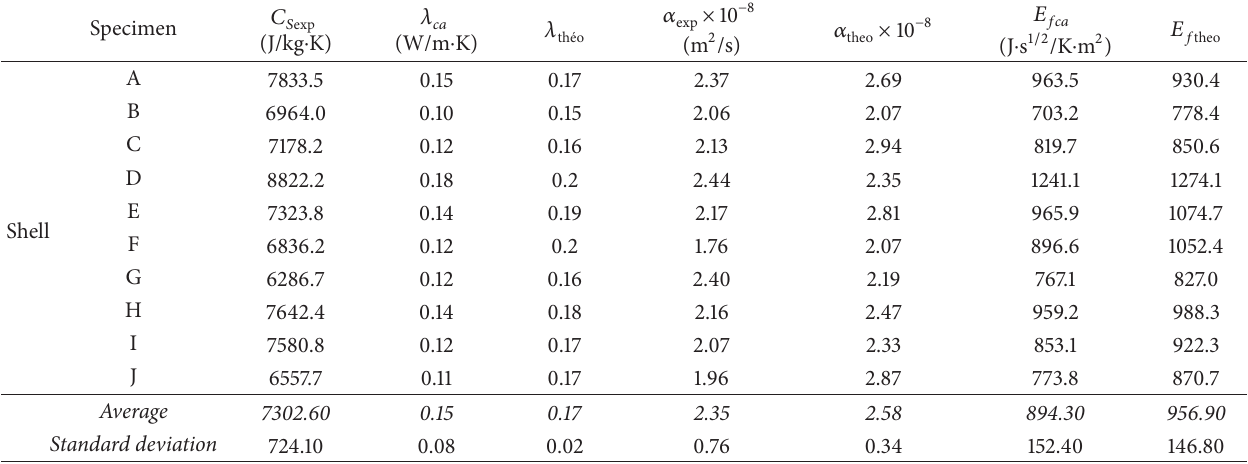
Table 4: Thermal capacity, diffusivity, conductivity, and effusivity of anhydrous marrow of raffia bamboo. Specimen